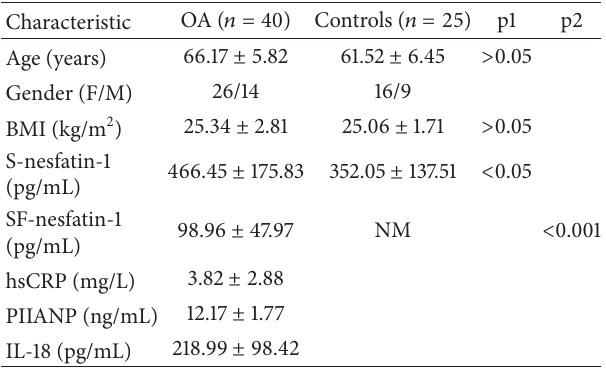
Table 1: Characteristics of patients with knee OA and healthy, non- OA